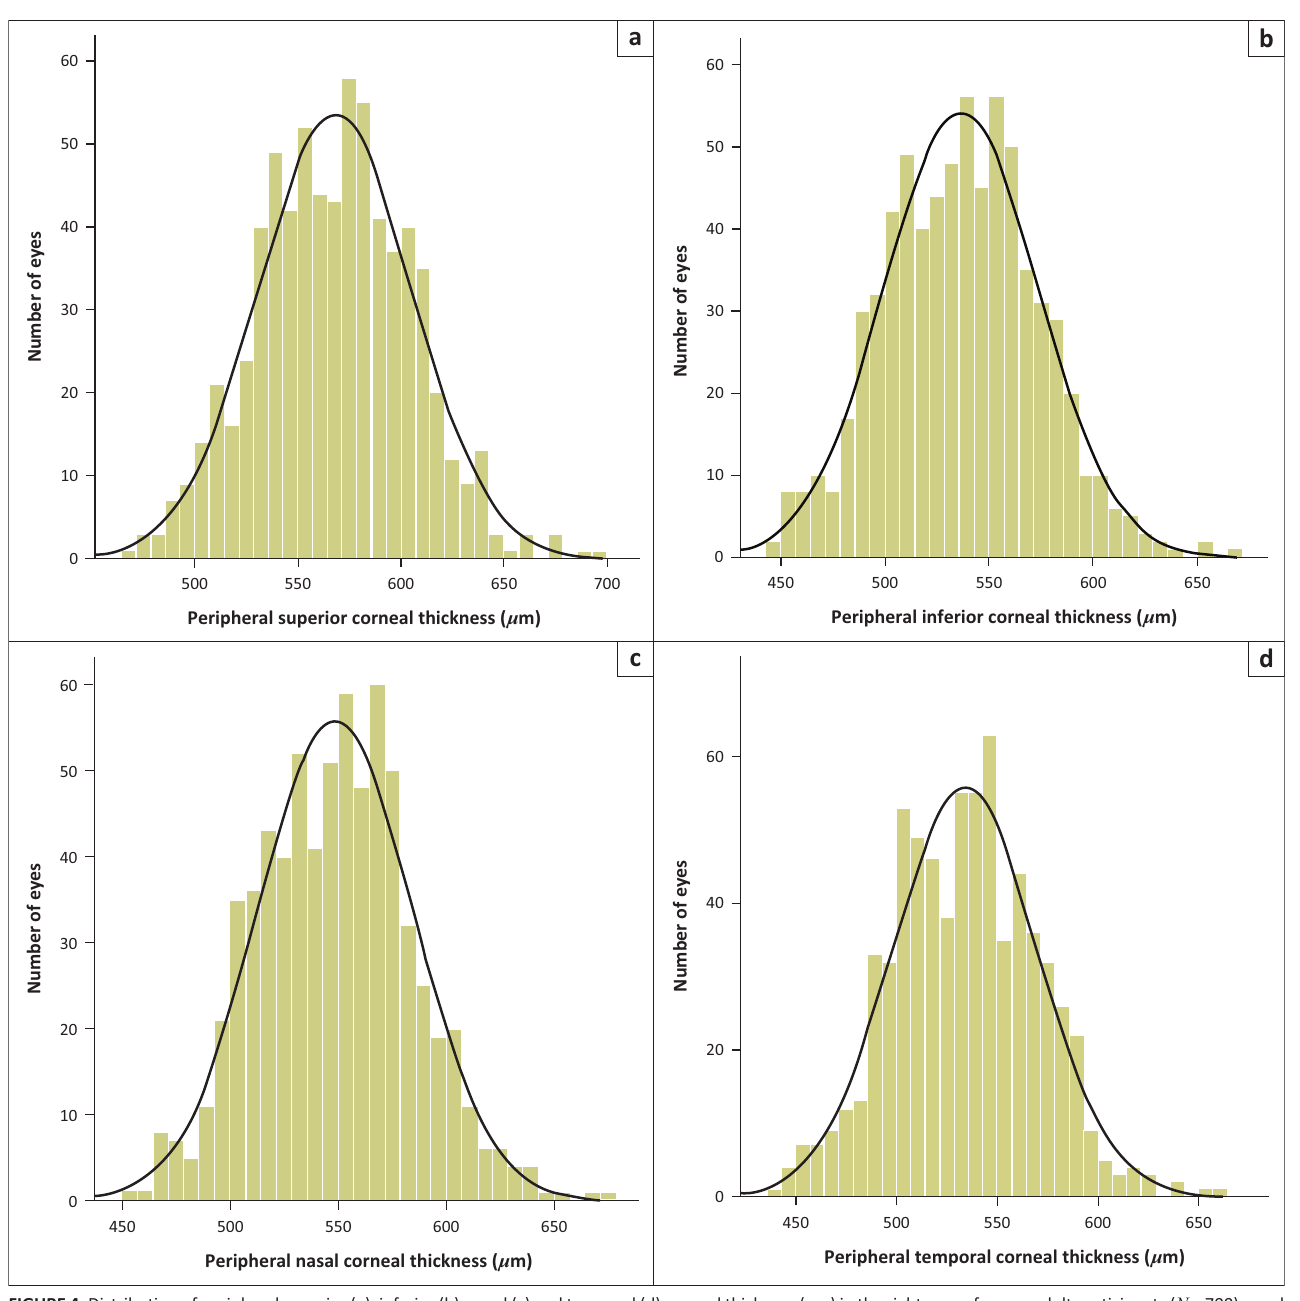
FIGURE 4: Distribution of peripheral superior (a), inferior (b), nasal (c) and temporal (d) corneal thickness ( µ m) in the right eyes of young adult participants ( N = 700), aged 17–30